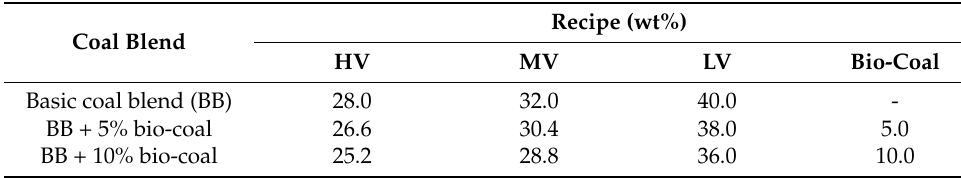
Table 4. The mixing ratio of coal blend with bio-coal (wt%).